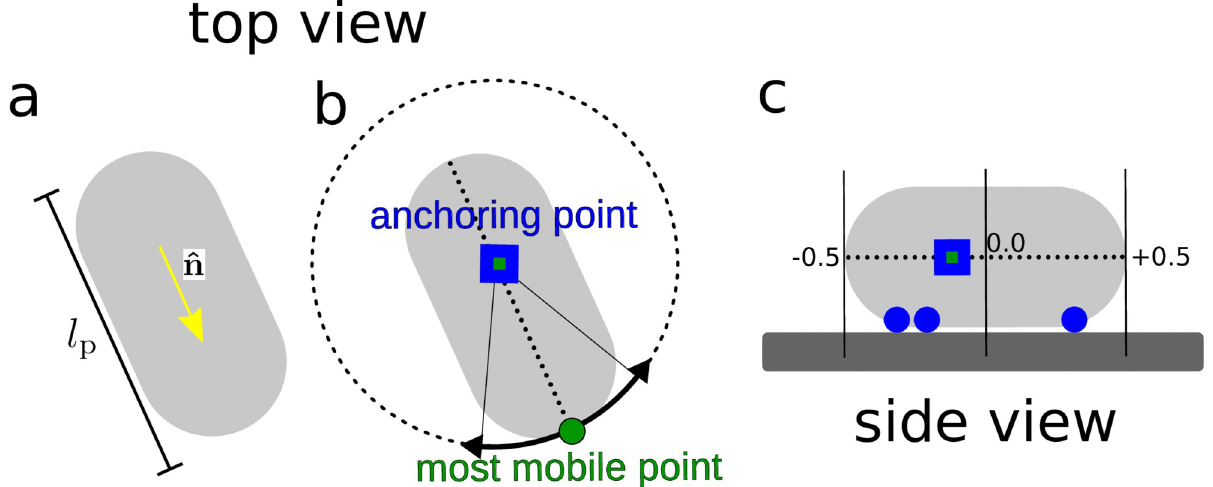
Fig 3. Schematic of an adhering cell. (a) showing the long axis and orientation, (b) anchoring point (least mobile point), and the most mobile point, and (c) side view showing an example where a cell is stuck at three adhesive spots (blue circles), the anchoring point (blue square with green centre) being the average of those; the numbers show the fractional coordinates f 2 [ − 0.5, 0.5], where f = 0 at the centre and f = ± 0.5 at the poles.